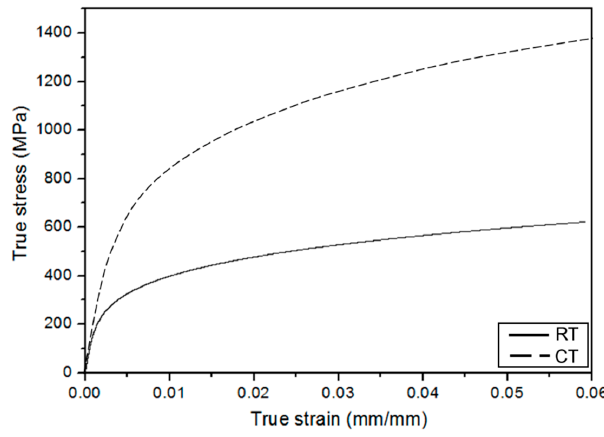
Figure 10. Cyclic stress–strain curves at room and cryogenic temperatures under R = − 1.